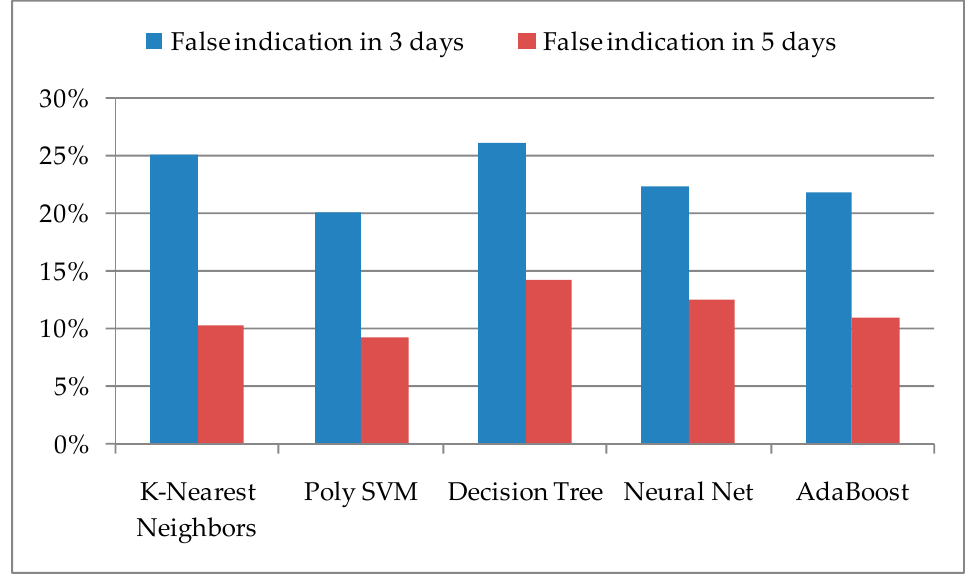
Figure 4. False prediction of the pest insect appearance according to the observed period and ML algorithms.